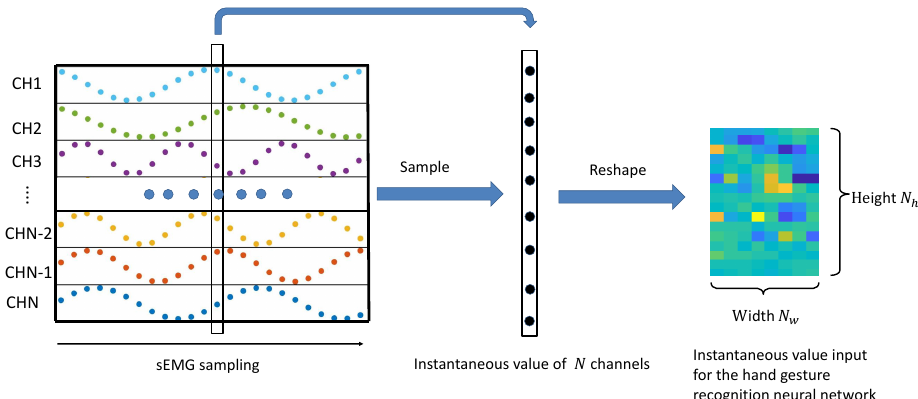
Figure 1. Input preparation process of the instantaneous gesture recognition network. CH de- notes channel.